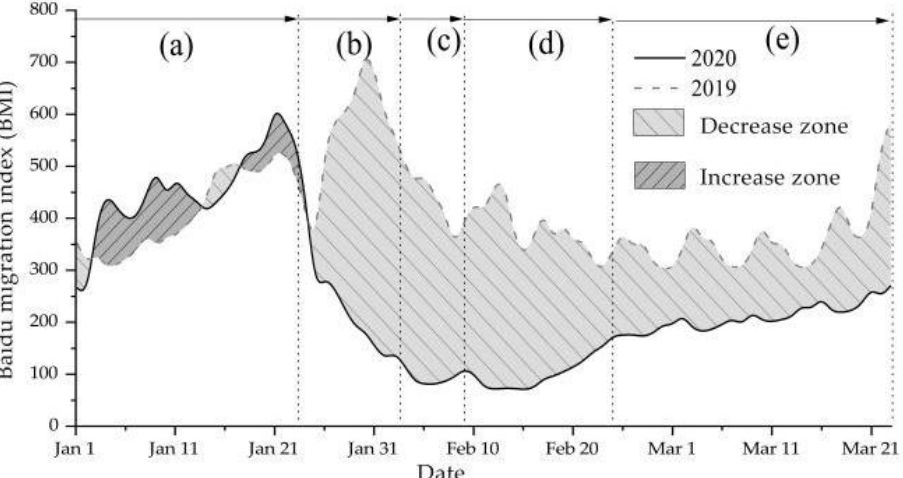
Figure 2. Comparison of trends of population mobility in China in 2020 and 2019. In order to facilitate comparative study, we convert the two sets of data in a unified way according to the lunar calendar, correspondingly, the data for 2019 are from 12 January 2019 to 4 April 2019. ( a – e ) represent five stages, which we distinguished earlier.